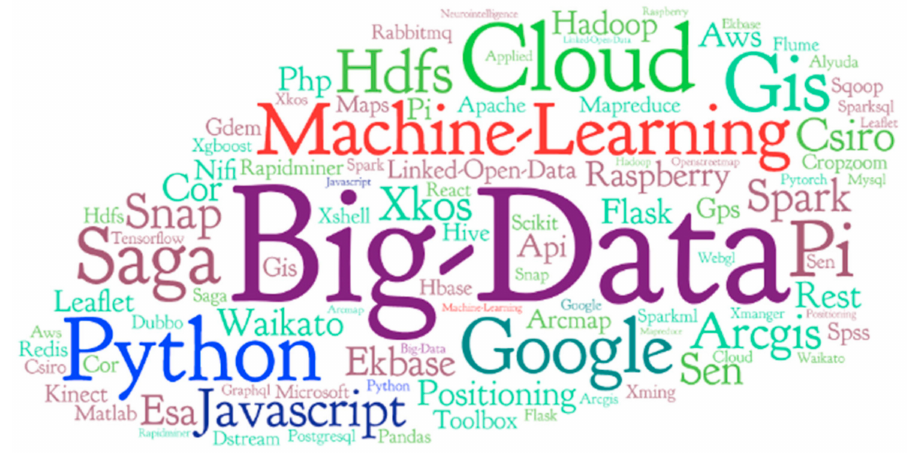
Figure 19. Cloud of Concepts of the Technologies